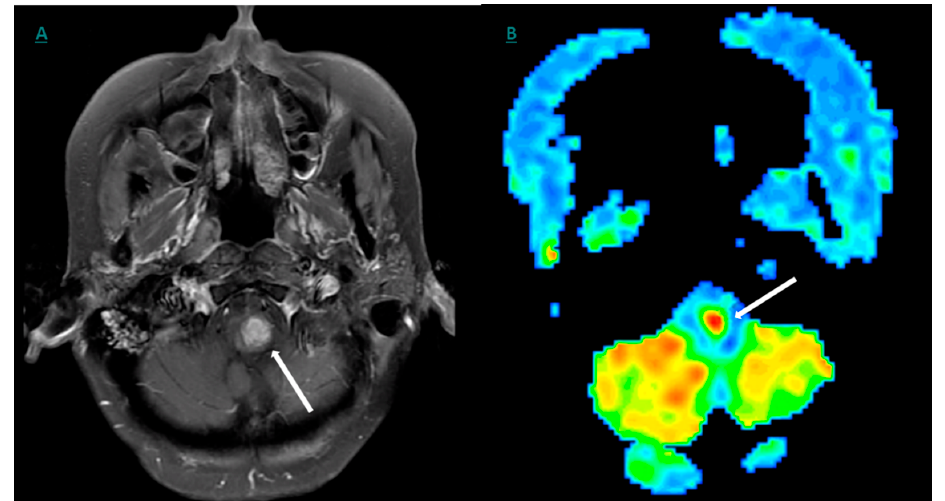
Figure 7. ( A ) DCE MRI axial T1-weighted image showing an enhancing cervicomedullary junction lesion (arrow). ( B ) The corresponding Arterial Spin Labeling (ASL) showing a relatively increased perfusion in the cervicomedullary junction